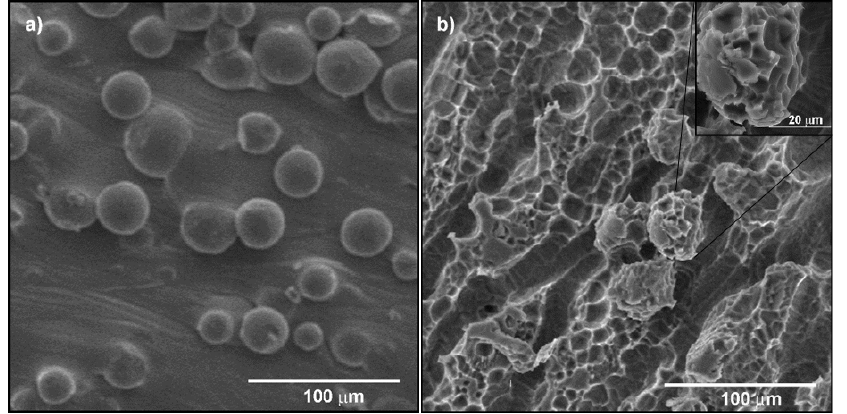
Figure 2. SEM micrographs of the surface of the Ti6Al4V alloy samples obtained by SLM before and after the acid etching (AE). ( a ) SLM surface, ( b ) AE surface (etched at 80 °C for 20 min). Inset: higher magnification image.